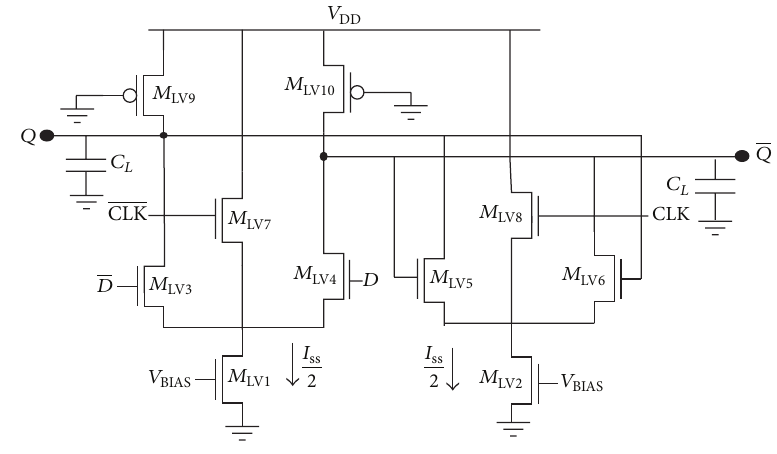
Figure 2: Proposed low-voltage D-latch. Table 1: Differential output voltages of the proposed D-latch for various input combinations. Differential